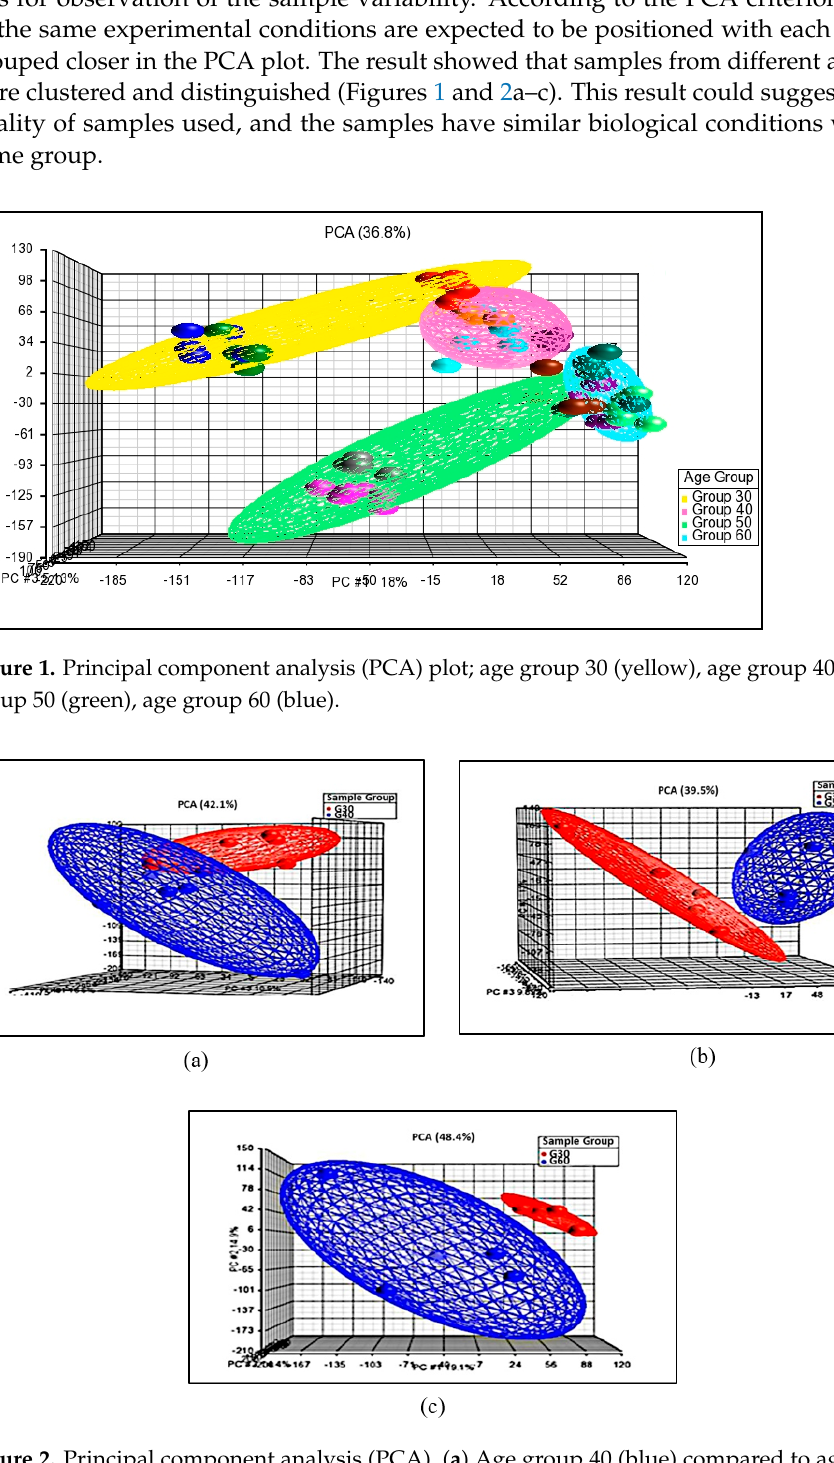
Table 2. RNA samples were used in the microarray experiment.